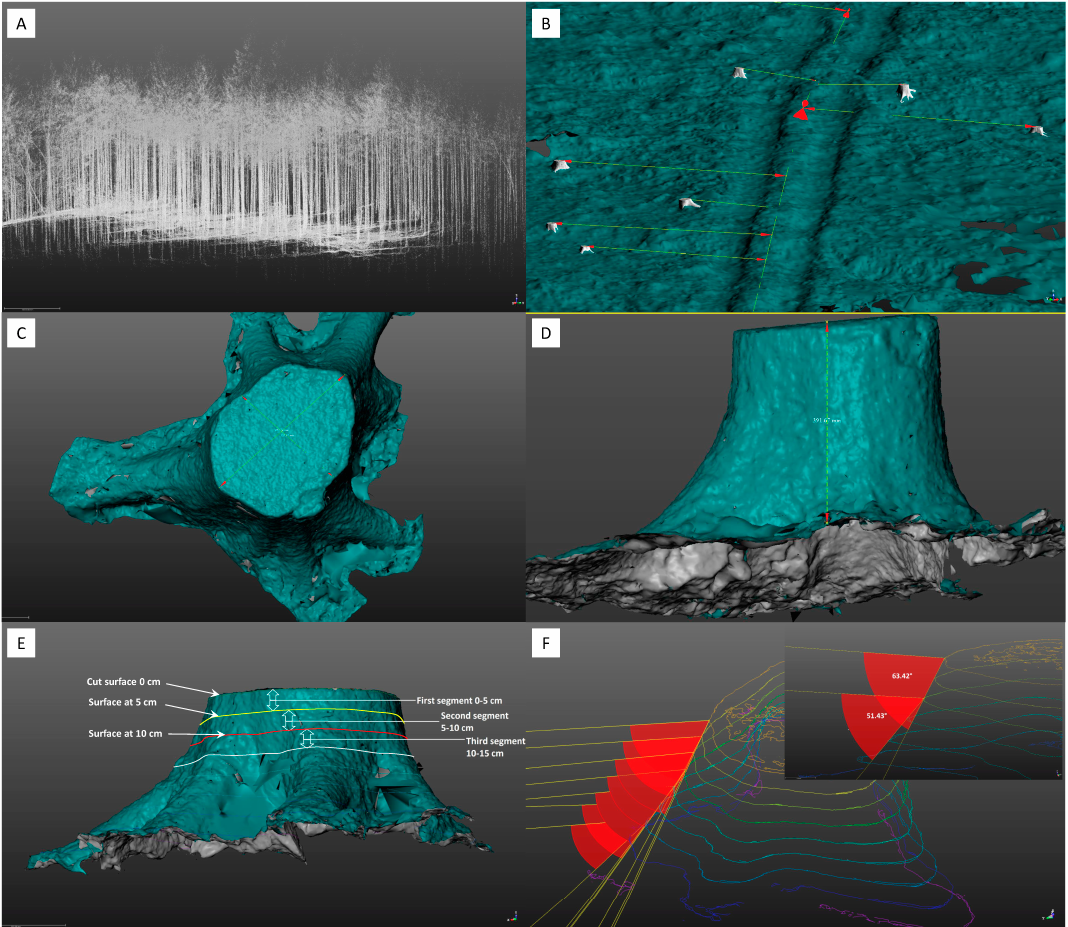
Figure 3. ( A ) Point cloud of the stand; ( B ) isometric-view of machine operating trail and stumps; ( C ) top-view of stump depicting the location of diameter measurements; ( D ) side-view of stump depicting height measurement; ( E ) side-view of stump showing the first three 5 cm segments and corresponding surfaces, and; ( F ) isometric-view of the angles measured for each layer and each root flare.